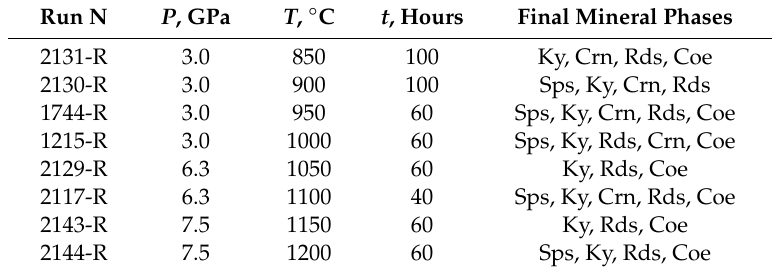
1200 60 Sps, Ky, Rds,